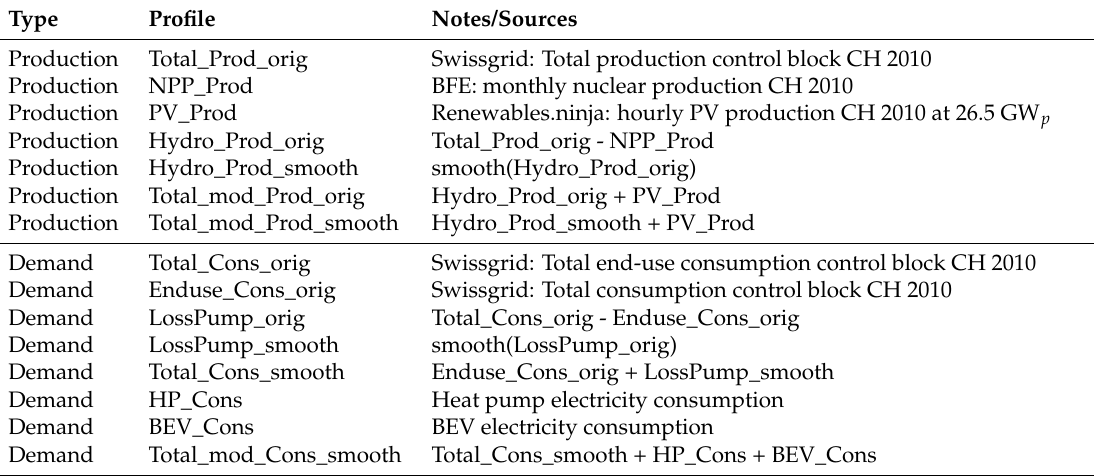
Table 1. Electricity production and consumption (demand) profiles used in this study